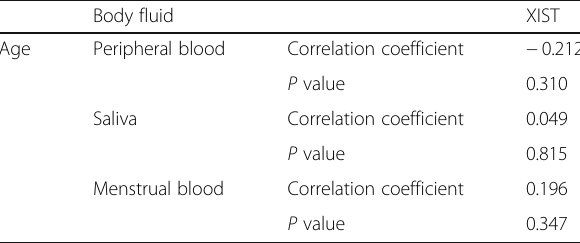
Table 7 Spearman ’ s correlation between participants ’ age and female XIST in the studied body fluids